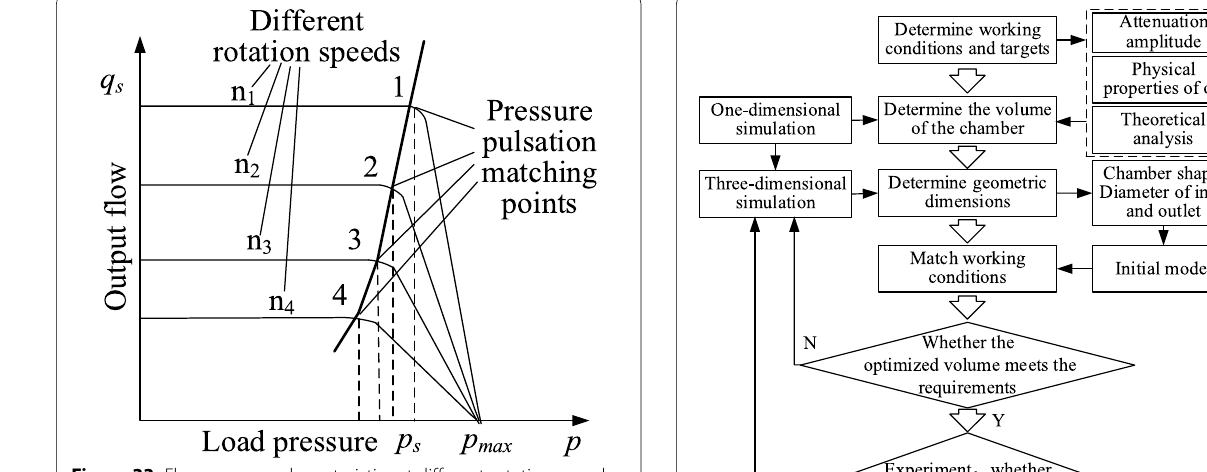
Figure 33 Flow-pressure characteristics at different rotation speeds